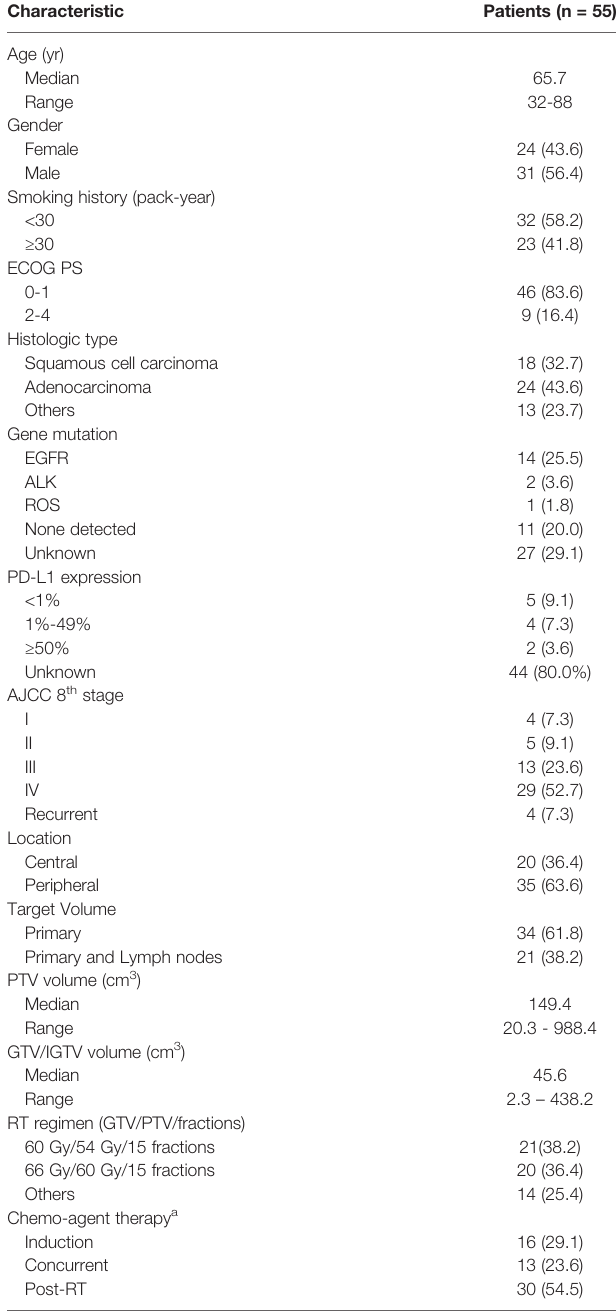
TABLE 1 | Patient, dosimetry and treatment characteristics.